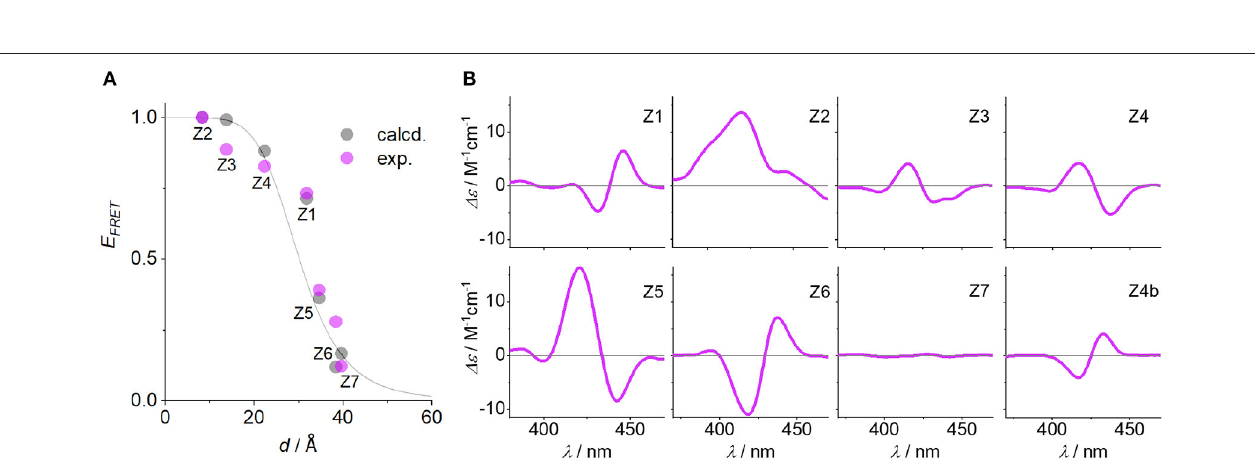
FIGURE 3 | (A) E FRET as function of Zn - P distance ( d ), comparing calculated (Preus et al., 2013) and measured FRET efficiencies (the gray line represents idealized behavior with κ 2 = 2/3). (B) CD spectra of the Zn - P duplexes (porphyrin region), including the CD spectrum of Z4b where the angle of the porphyrin dipole moment has opposite sign to Z4 . Conditions as in Figure 2